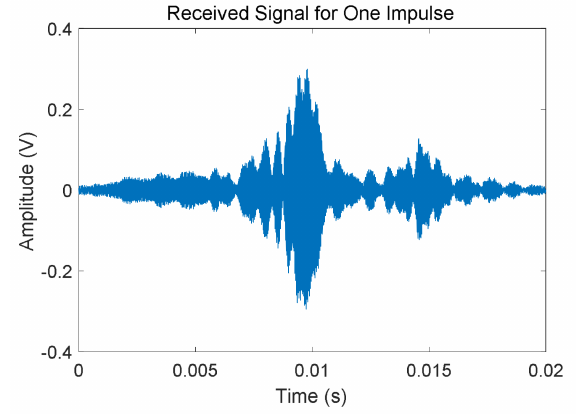
Figure 6. Zoom of an UGW train of pulses received for a free track section.